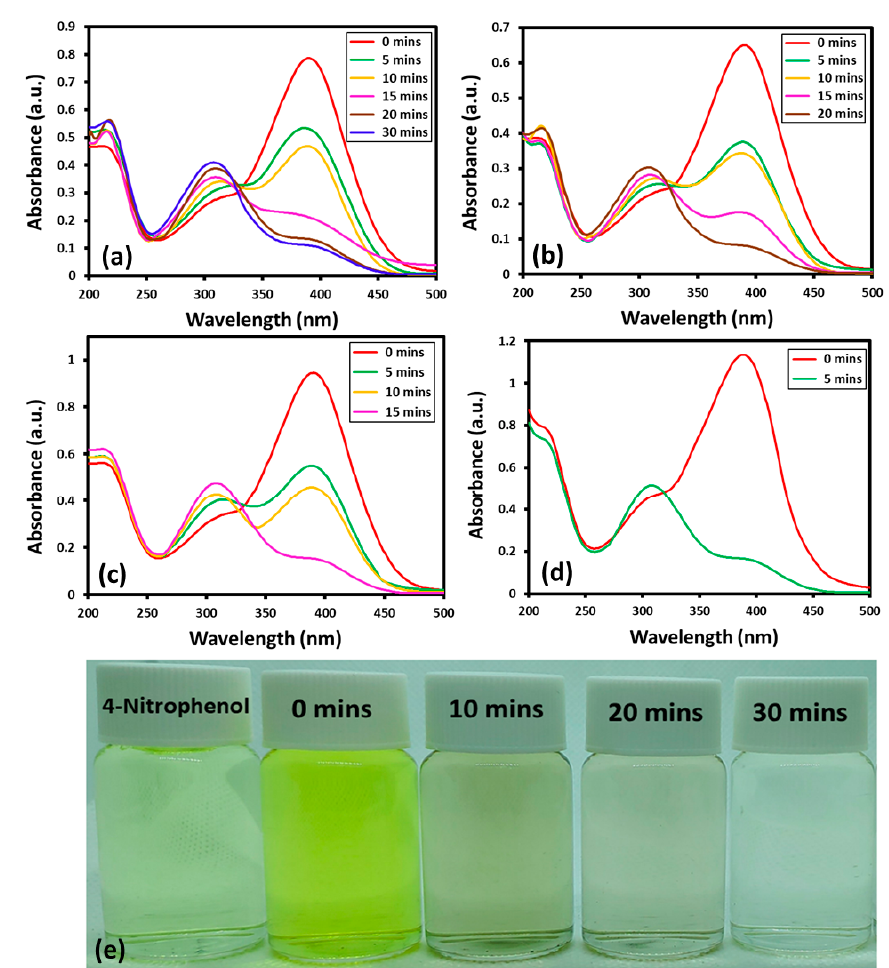
Figure 5. UV spectra of 4-nitrophenol reduction by the addition of different volumes of Au-ZrO 2 nanocatalyst: ( a ) 0.25 mL, ( b ) 0.5 mL, ( c ) 0.75 mL, ( d ) 1.00 mL, and ( e ) digital photos of the color transformation during the conversion of nitrophenol to aminophenol the amount of nanocatalyst was taken from freshly prepared dispersion of Au-ZrO 2 with a concentration of 0.25 mg/mL.